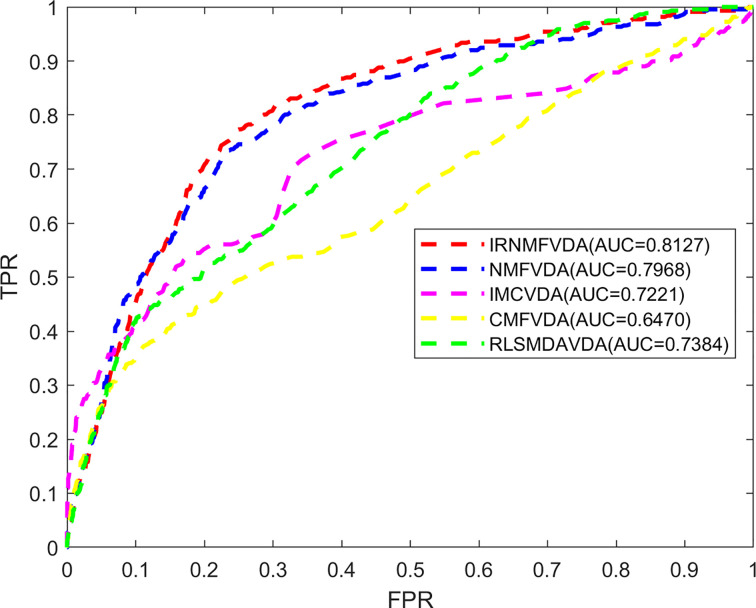
The comparison of methods. IRNMFVDA, NMF, IMCVDA, CMFVDA, RLSMDAVDA of ROC curve and AUCs value based on 5-fold CV.